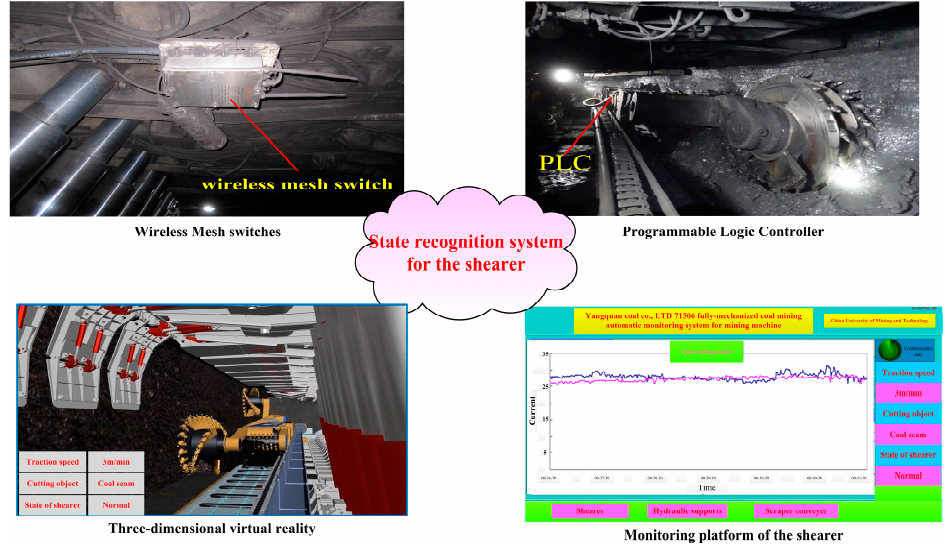
Figure 7. State recognition system for the shearer. Table 2. The shearer running log.